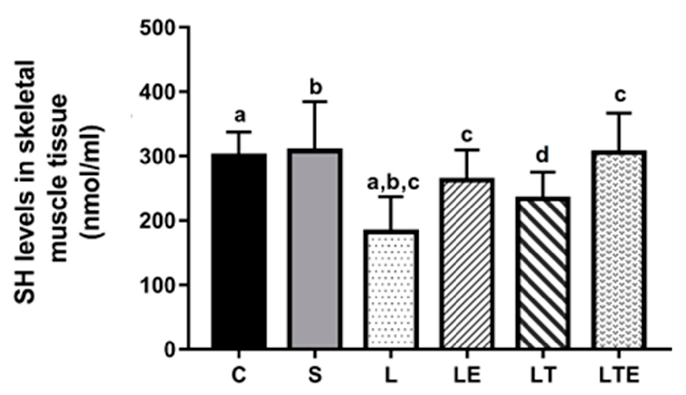
Figure 7. Evaluation of SH levels in the right gastrocnemius muscle. Sulfhydryl levels in the gastrocnemius muscle (nmol / mL) after interventions in the di ff erent groups: C, control group; S, sham group; L, injury group; LE, injury + extract group; LT, injury + training group; LTE, injury + training + extract group. Equal The letters “a”, “b”, “c” and “d” when repeated indicate statistical di ff erences between the groups as determined by one-way ANOVA with Bonferroni post-hoc correction.